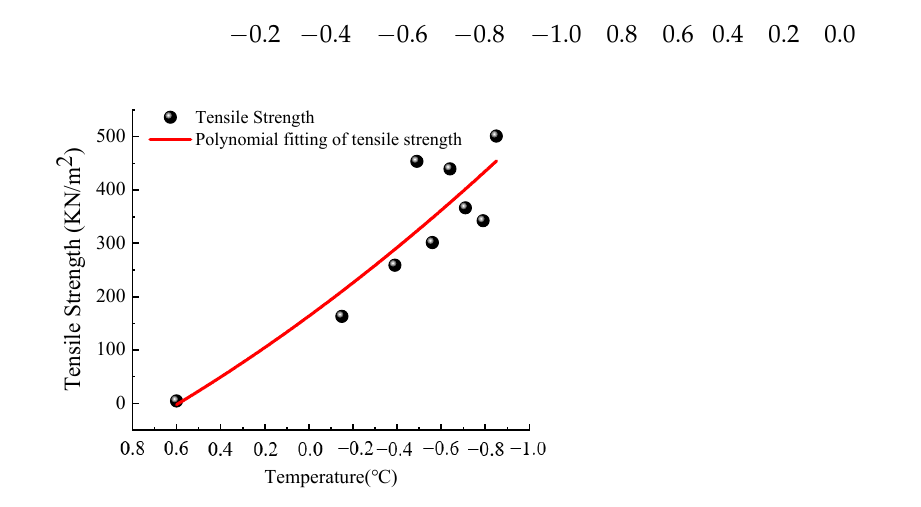
Figure 5. The relationship between the tensile strength of the soil in the frozen fringe and the freezing temperature.